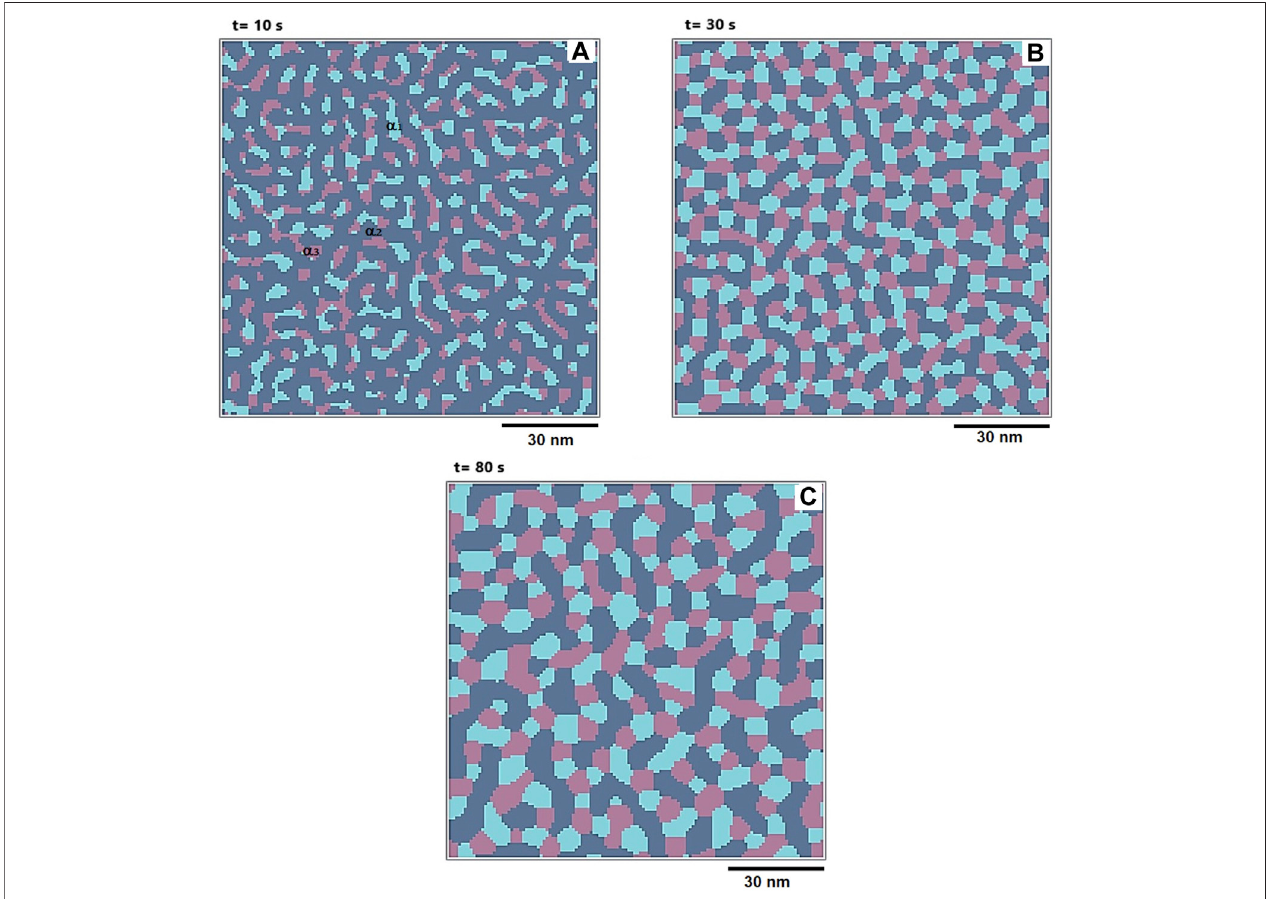
FIGURE 8 | Simulated microstructure of the A – B – C alloy for case II with X A = 0.3 , X B = 0.4 , and X c = 0.3 aged at 800 K for (A) 10 s, (B) 30 s, and (C) 80 s.